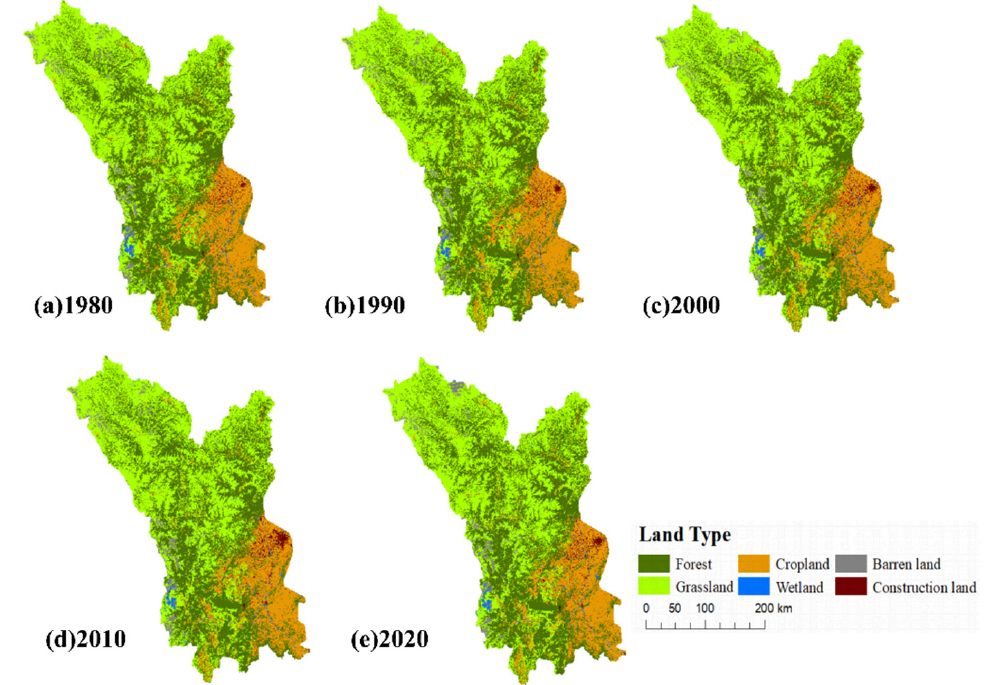
Figure 5. Land use map of the Min River basin in different periods. Table 6. Changes of land use types in different periods in the Yangtze River basin.